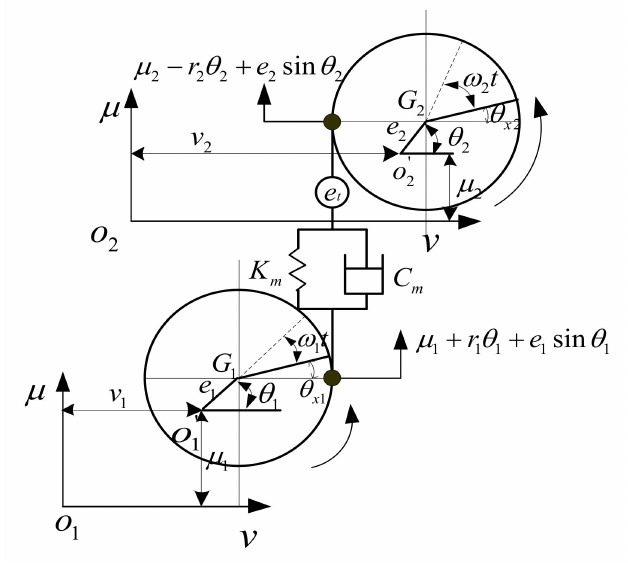
Figure 7. The gear pair dynamic